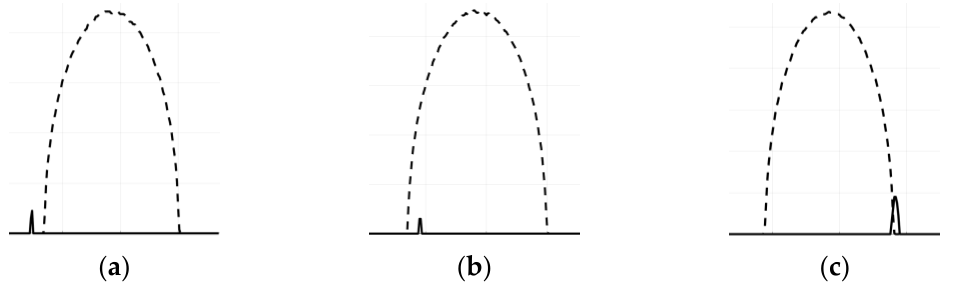
Figure 3. ER between sinograms of an ellipse and a base square. ( a ) Separation; ( b ) Inclusion; ( c ) Intersection.